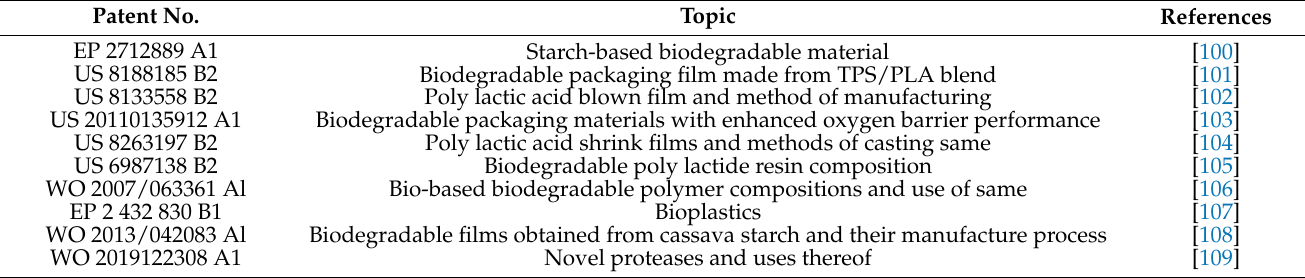
Table 4. List of patents for the biopolymers based on starch and PLA. Data adapted from [98]. Patent No.